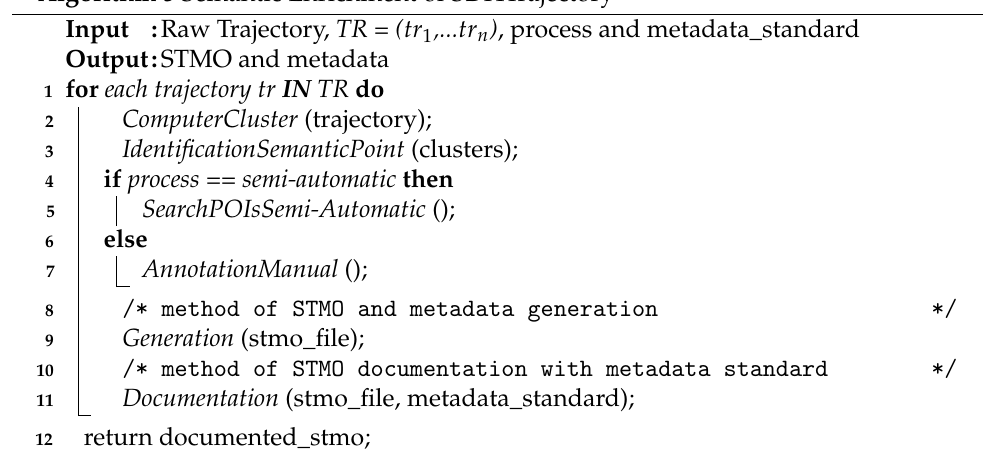
Algorithm 5 Semantic Enrichment of SDI4Trajectory